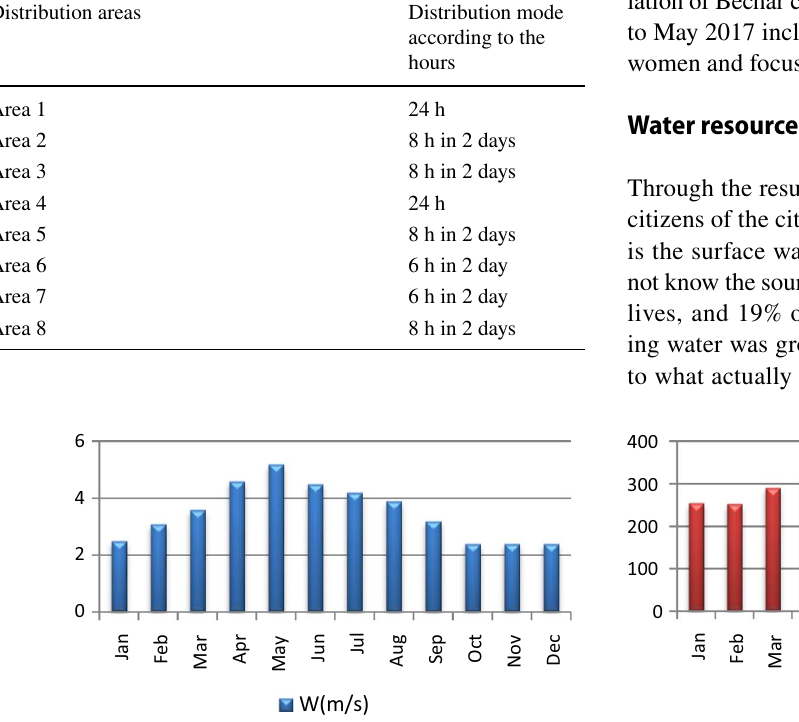
according to the